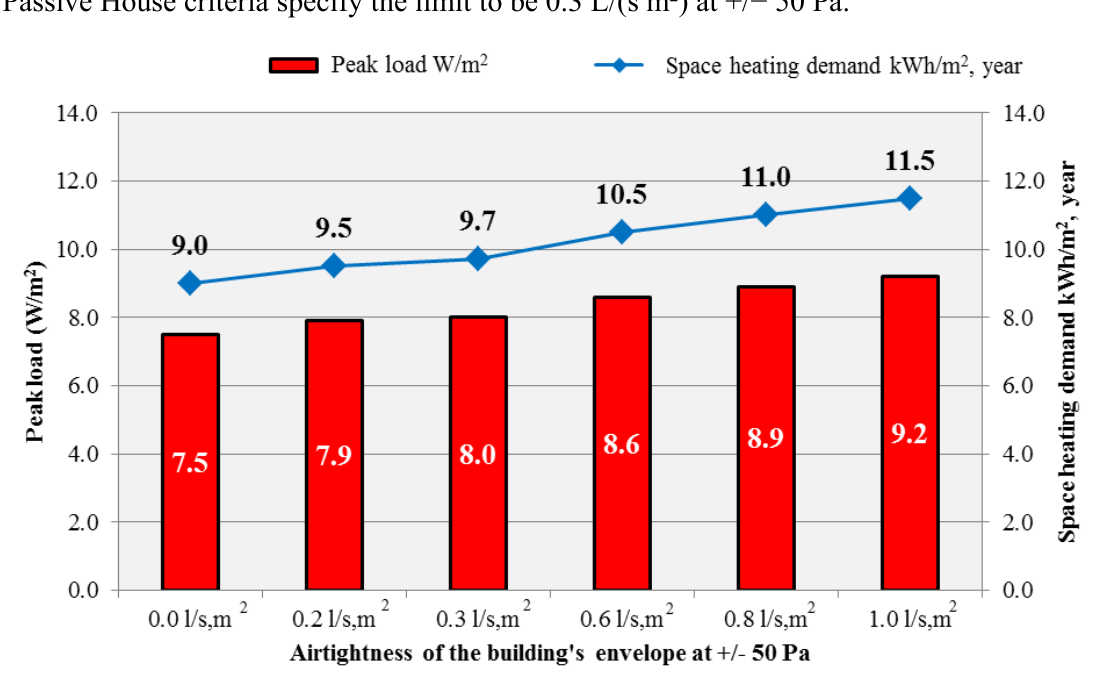
Figure 3. Peak load and space heating demand for different airtightness of the building’s envelope. The design target was 0.2 L/(s m²) at +/− 50 Pa, whereas the Swedish voluntary Passive House criteria specify the limit to be 0.3 L/(s m²) at +/− 50